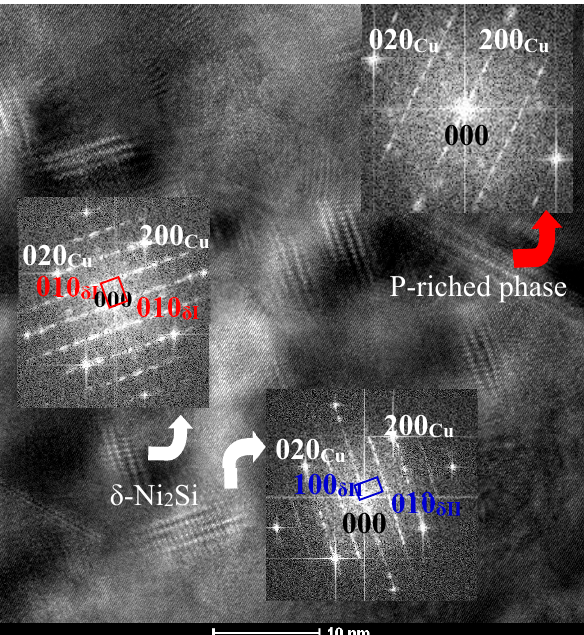
Figure 7. HREM image of C0 alloy aged at 500 °C for 15 min and corresponding FFT patterns of precipitates.